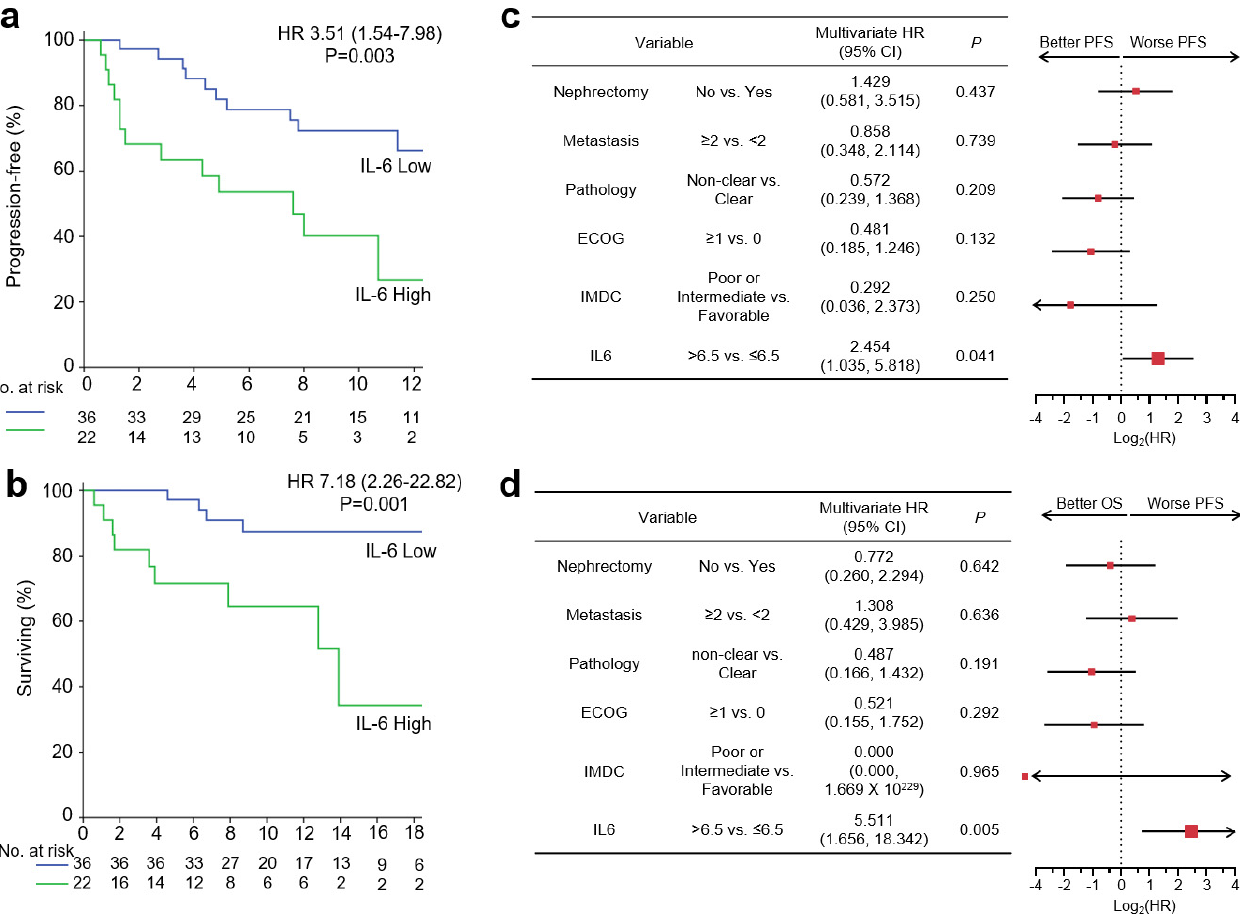
Figure 3. Baseline serum IL ‐ 6 levels and survival outcome with pembrolizumab/axitinib therapy. IL ‐ 6 > 6.5 pg/mL was defined as IL ‐ 6 High. ( a ) Kaplan–Meier curves showing PFS according to IL ‐ 6 level. ( b ) Kaplan–Meier curves showing OS according to IL ‐ 6 level. ( c ) Forest plots showing PFS according to nephrectomy, metastasis, pathology, Eastern Cooperative Oncology Group (ECOG) performance status, International Metastatic Renal Cell Carcinoma Data Consortium (IMDC) risk criteria, and IL ‐ 6 status. ( d ) Forest plots showing OS according to nephrectomy, metastasis, pathol ‐ ogy, ECOG performance status, IMDC risk criteria, and IL ‐ 6 status. Hazard ratios and 95% confi ‐ dence intervals are shown in survival curves and forest plots. Multivariate analyses were conducted using Cox proportional hazard regression. PFS, progression ‐ free survival; OS, overall survival.